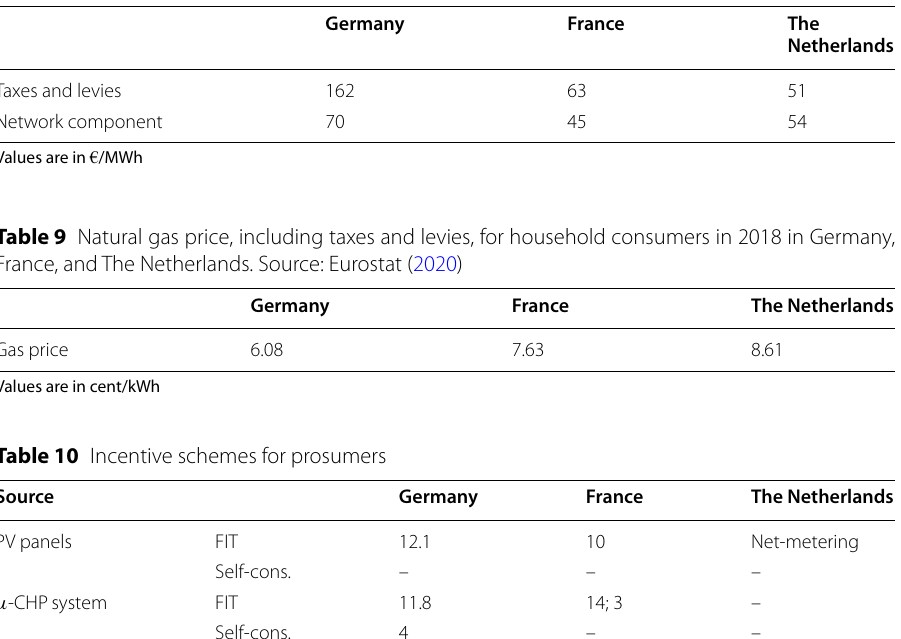
Table 8 Taxes and network components assumed for residential users in Germany, France, and The Netherlands. Source: European Commission (2019)